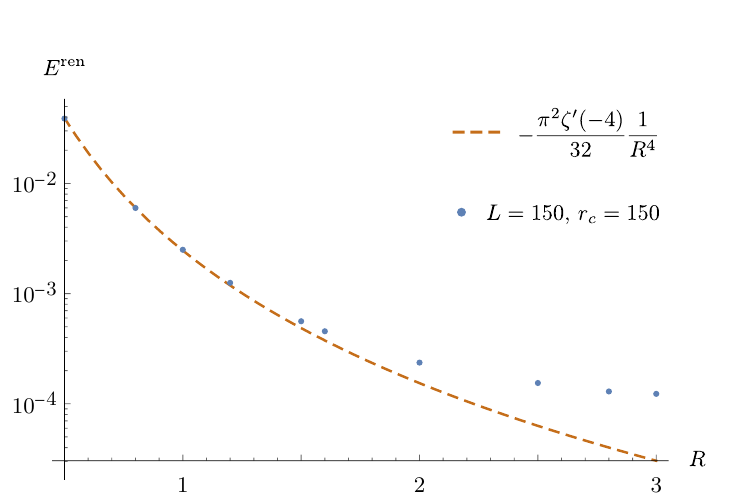
Figure 9 . Log-plot of the Casimir energy, calculated numerically (blue data points) for a = 0 . 1 , r c = 150 and L = 150 . The brown dashed curve represents the standard (5D) Casimir energy (due to Dirichlet boundary conditions). We plotted the absolute values.